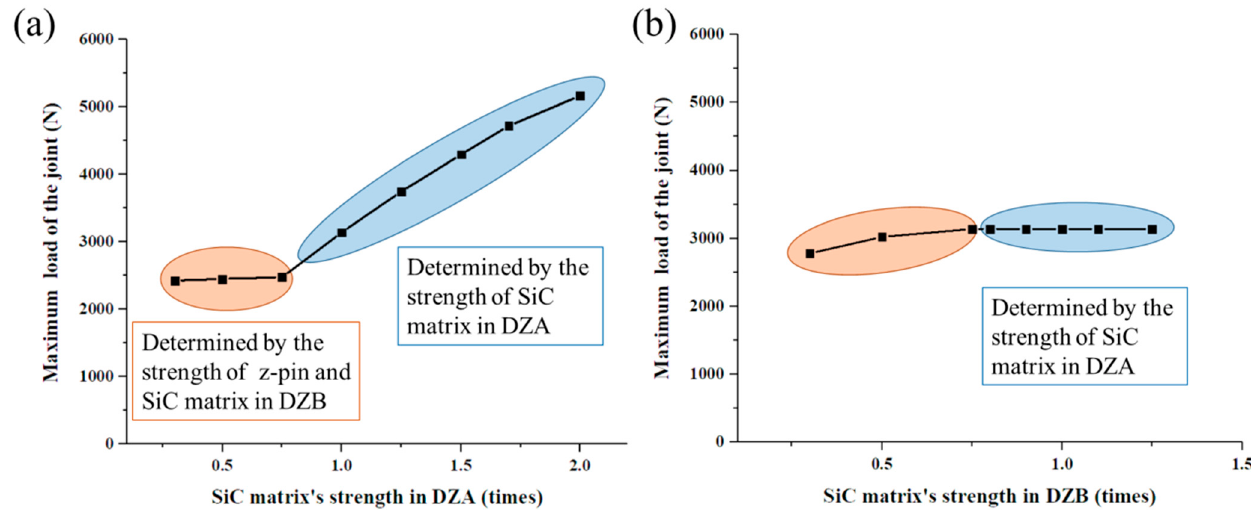
Figure 16. The relationship of the joint’s maximum load and the deposited SiC matrix’s strength in ( a ) DZA; ( b ) DZB.